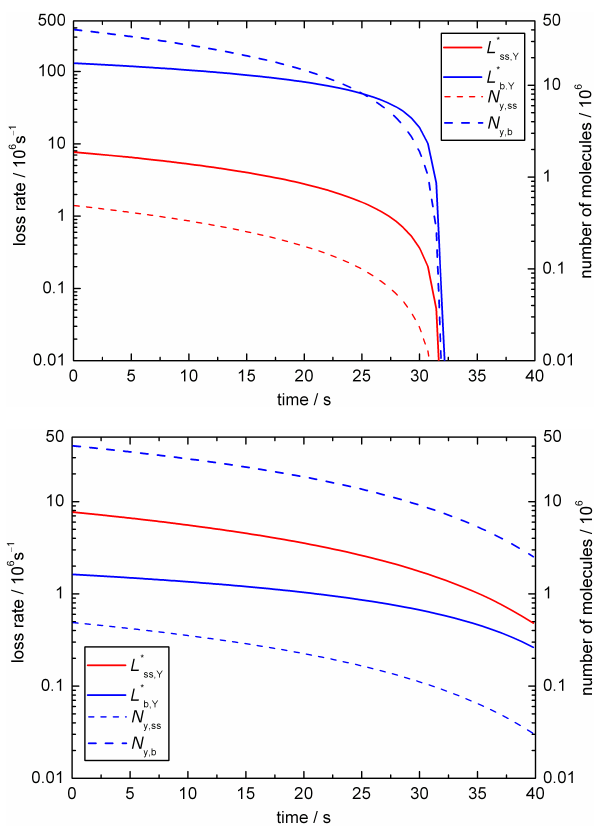
Fig. 3. Temporal evolution of aerosol particle composition and ki- netic parameters in sensitivity studies for BC1 with K sol , cp , X (a) eight fold above the literature value and (b) ten fold below. Plots are analogous to Fig. 2c.